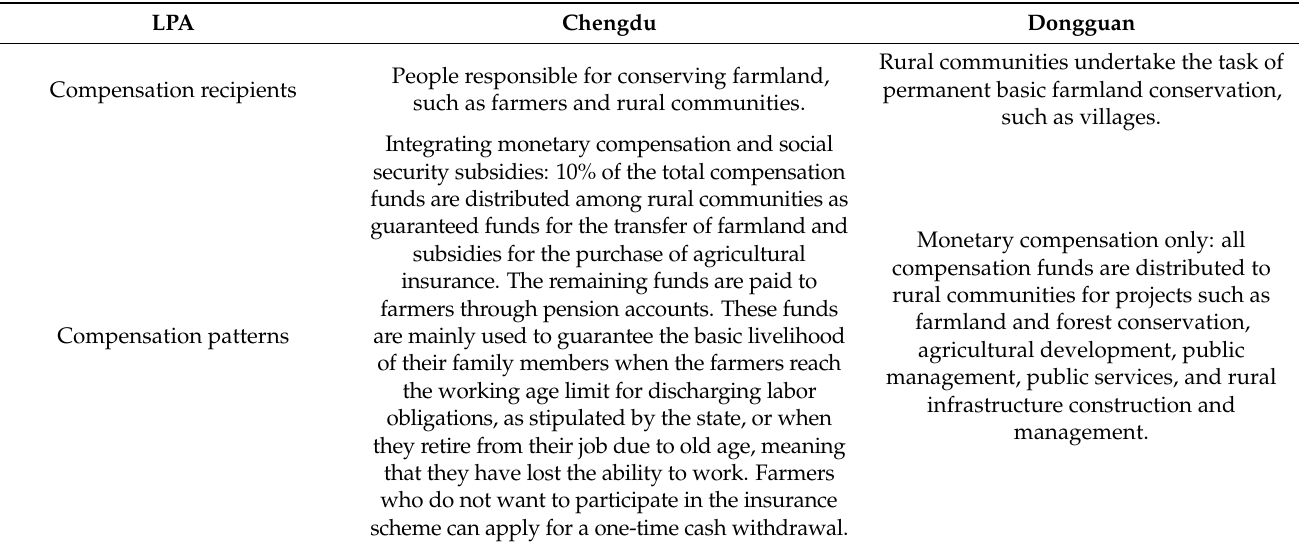
Table 1. Comparison between FCP-LE: Chengdu vs. Dongguan. LPA Compensation